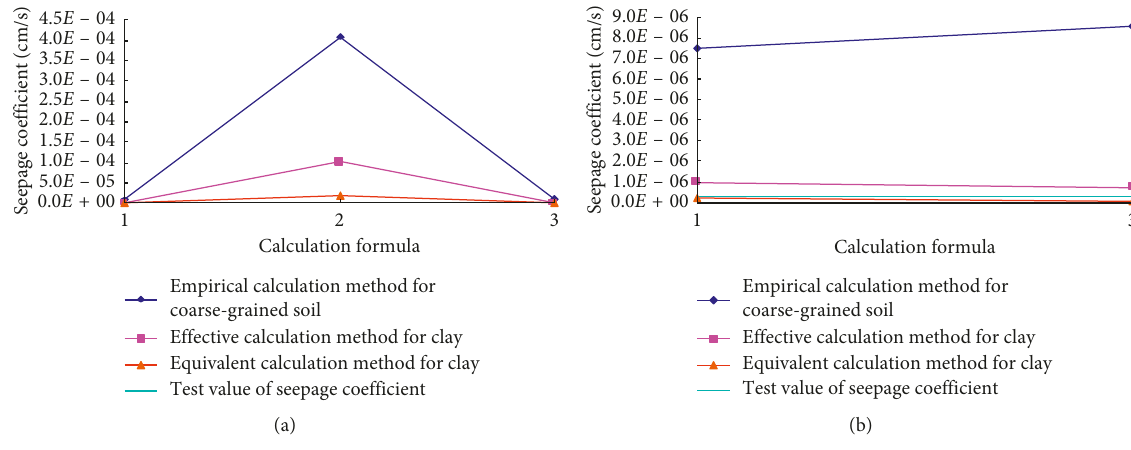
Figure 7: Seepage coefficients of clay from South China Sea under (a) formulas (1)–(3) and (b) formulas (1) and